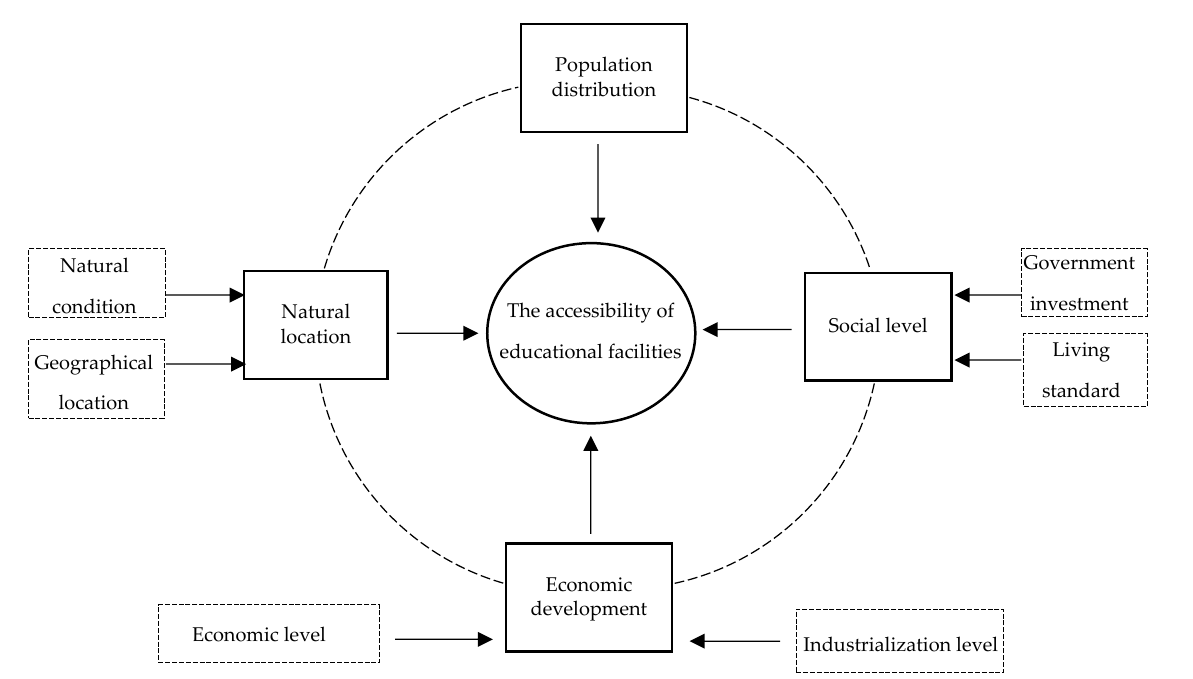
Figure 7. Framework of impact mechanism on accessibility of educational facilities in the YGGRD.